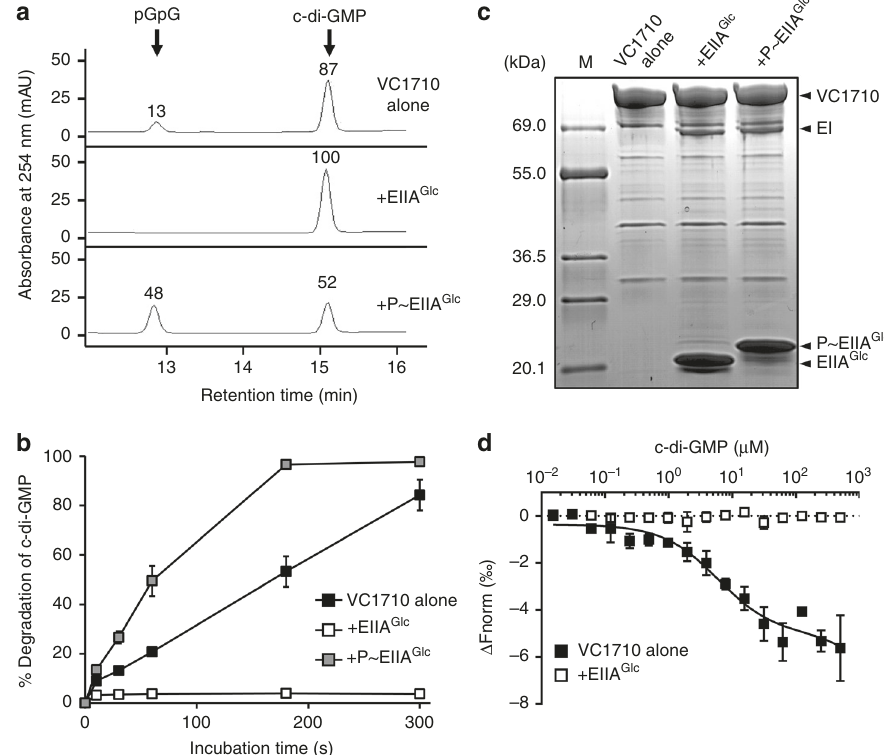
Fig. 2 EIIA Glc modulates the PDE activity of VC1710. a The c-di-GMP phosphodiesterase (PDE) activity of VC1710 (4.1 μ M) was assayed in a reaction mixture containing 20 μ M of c-di-GMP and 0.4 μ M of EI and HPr in the absence or presence of puri fi ed EIIA Glc (17.1 μ M). EIIA Glc in the reaction mixture was phosphorylated by adding 2 mM PEP. The reaction mixtures were applied to a Supercosil LC-18-T HPLC column, and the remaining c-di-GMP and produced pGpG were quanti fi ed by measuring absorbance at 254 nm. b The c-di-GMP hydrolysis activity of VC1710 was assessed in the absence (black square) and presence of EIIA Glc (white and gray squares) as in panel a and c-di-GMP and pGpG were analyzed at 0, 10, 30, 60, 180, and 300 s. c The phosphorylation state of EIIA Glc in panels a and b was con fi rmed by SDS – PAGE and staining with Coomassie brilliant blue R. d The binding af fi nities of PdeS with c-di-GMP in the absence (black square) or presence (white square) of dephosphorylated EIIA Glc were measured using NanoTemper Monolith NT.115 pico . An excess amount (5 μ M) of EIIA Glc was added to the reaction mixture to ensure all the VC1710 existed as a complex with EIIA Glc . Shown are the means and SD ( n = 3, independent